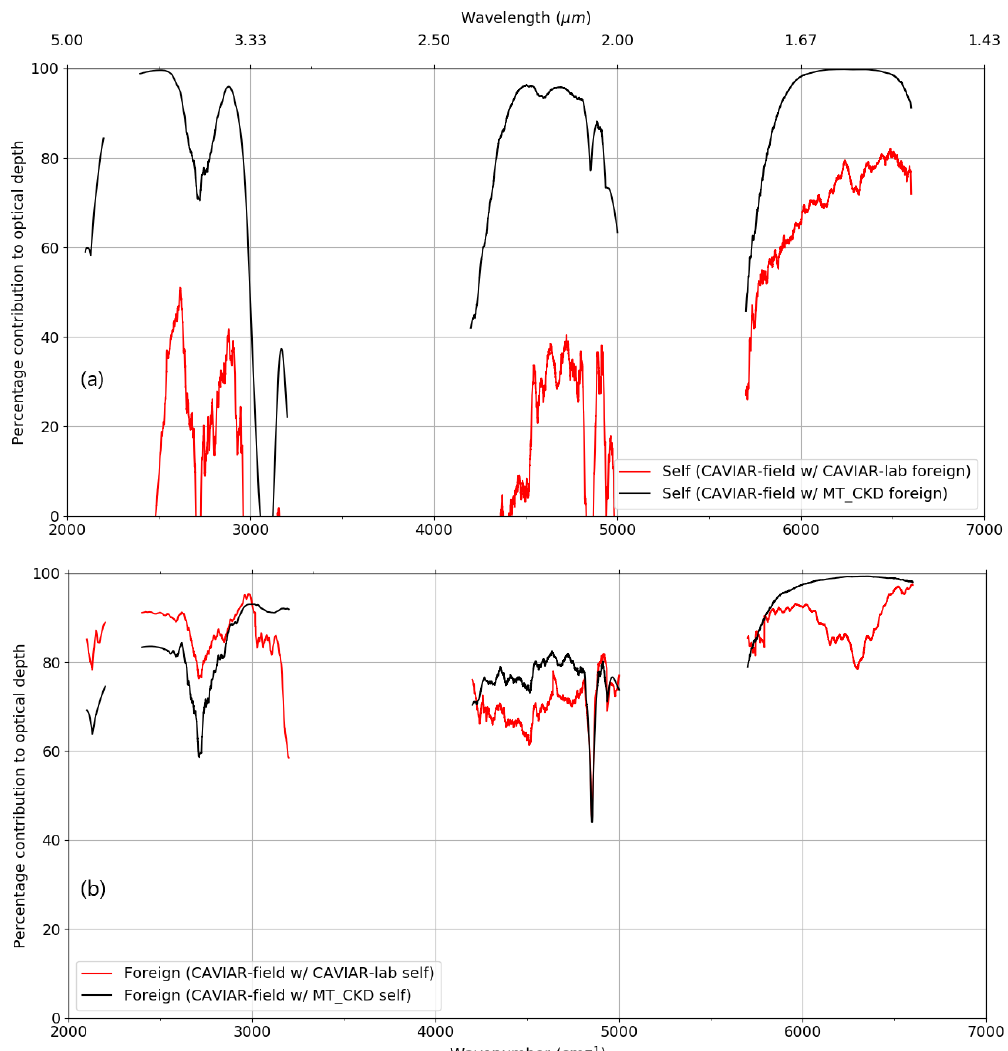
Figure 19. Proportion of the total continuum optical depth for 18 September 2008 from the CAVIAR-field self-continuum assum- ing the CAVIAR-lab and MT_CKD_3.2 foreign continua ( a ) and the CAVIAR-field foreign continuum assuming the CAVIAR-lab and MT_CKD_3.2 self-continua ( b ). As explained in the text, these are insufficient data to constrain the field observations such that the per- centage contributions of the self-continuum and foreign continuum sum to 100%, given the methodology to derive the self and foreign components of the field